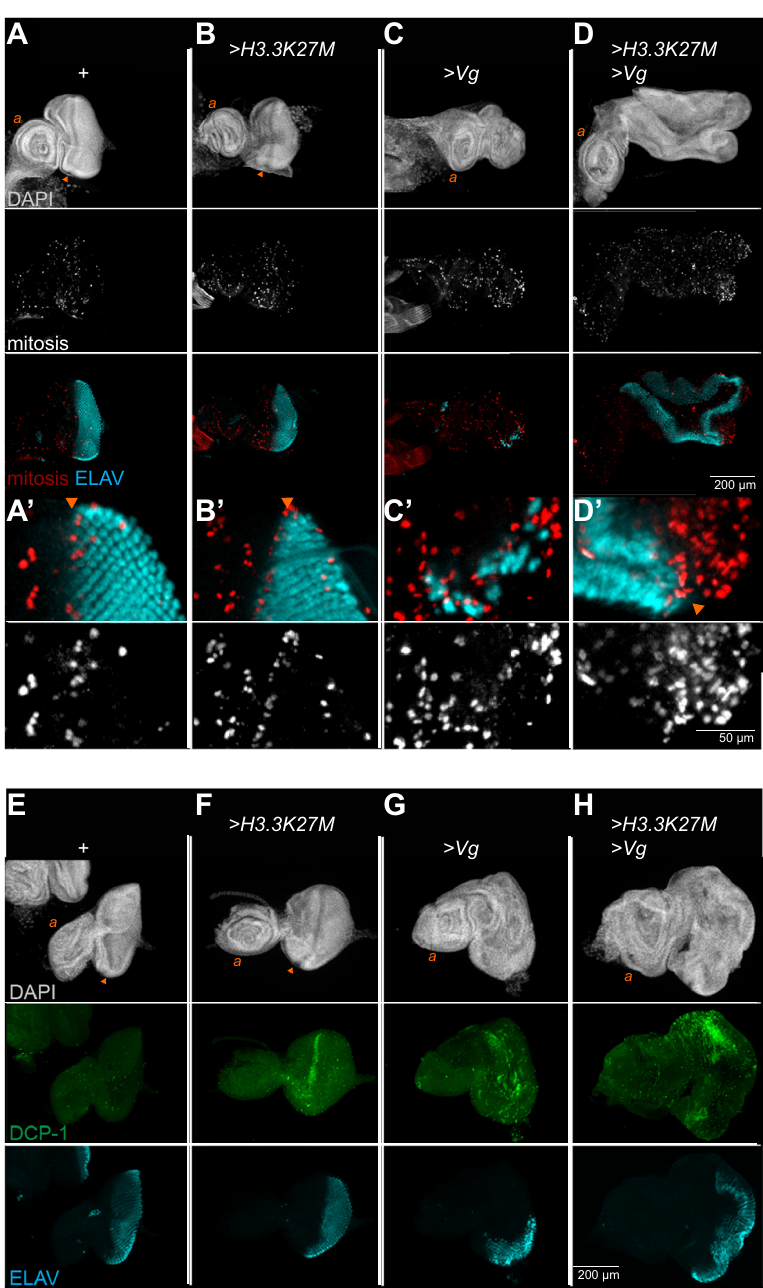
Fig 3. H3.3K27M and Vg stimulate cell death and proliferation. ( A-D ) Eye-antennal discs immunostained for the H3S10-phosphorylation marker of mitosis ( A-D ) with higher magnification imaging around the morphogenetic furrow (arrowheads, A’-D’ ). ( E-H ) Discs immunostained for the cleaved DCP-1 marker of apoptosis ( E-H ). The wildtype ‘+’ strain was w 1118 , and all discs were immunostained for ELAV. animals have very small eyes with no wing tissue outgrowths ( Fig 4A ). This implies that tran- sient production of Vg activates endogenous genes for wing specification. The endogenous vg gene is also required for overgrowth of eye discs with oncohistone and ectopic Vg expression, as a dominant negative vg U allele reduces eye size ( Fig 4B ).